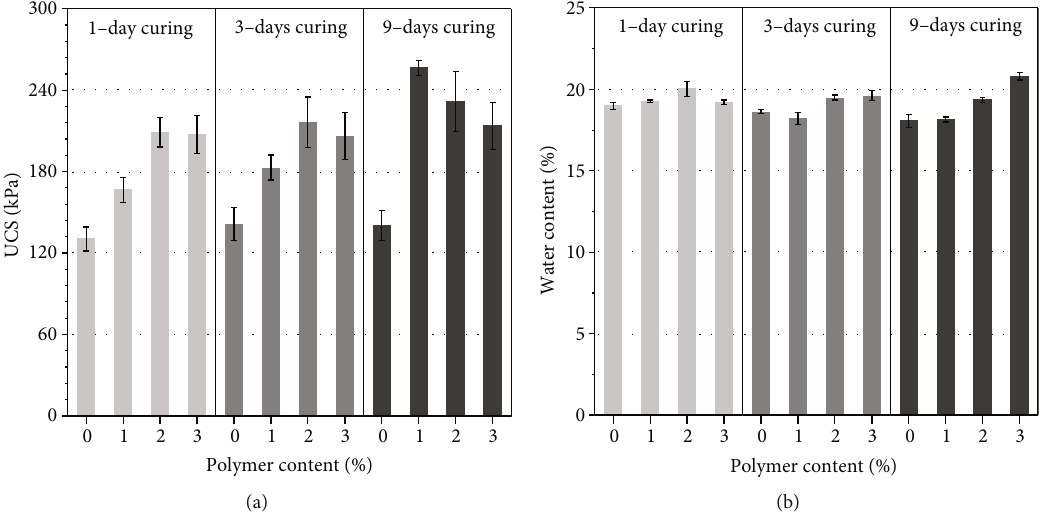
Figure 3: Results of the polymer-treated specimens cured in optimum water content condition. Variations of (a) compressive strength and (b) water content of the specimens after 1, 3, and 9 days of